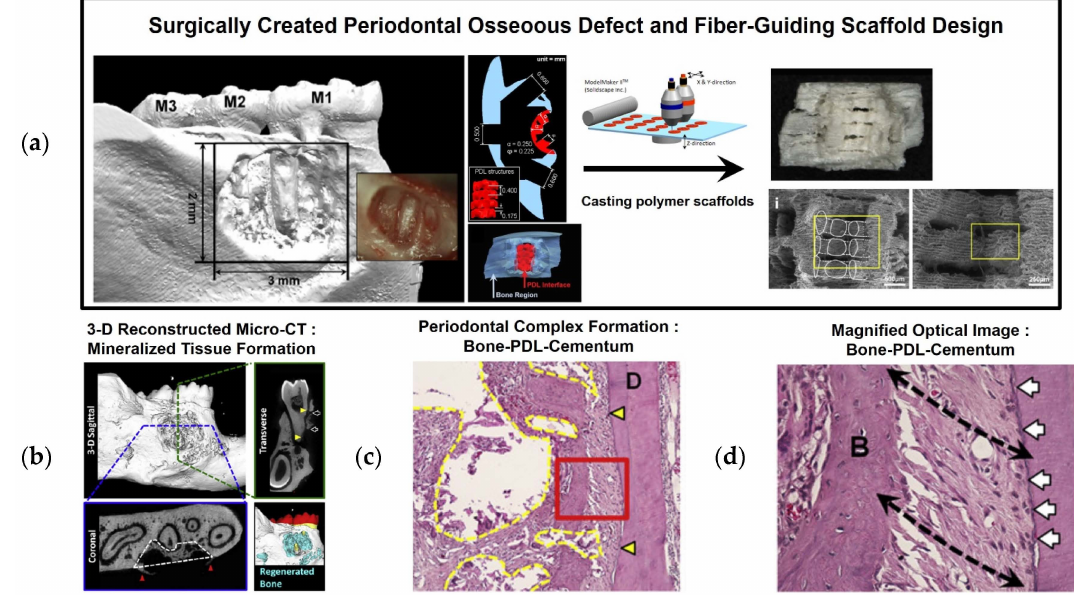
Figure 6. Preclinical study using image-based 3-D printing technology for periodontal complex regeneration. ( a ) After surgically creating the periodontal fenestration defect on the buccal side of a mandible, customized fiber-guiding scaffolds were designed and manufactured using 3-D printed wax molds. ( b ) 3-D reconstructed micro-CT and ( c , d ) histological image assessments for bone-PDL-cementum. D: dentin; B: bone; yellow triangles: surgically created defect regions on the dentin surface; black dashed arrows: fibrous tissue orientation; white arrows: calcified layer deposition on the dentin surface